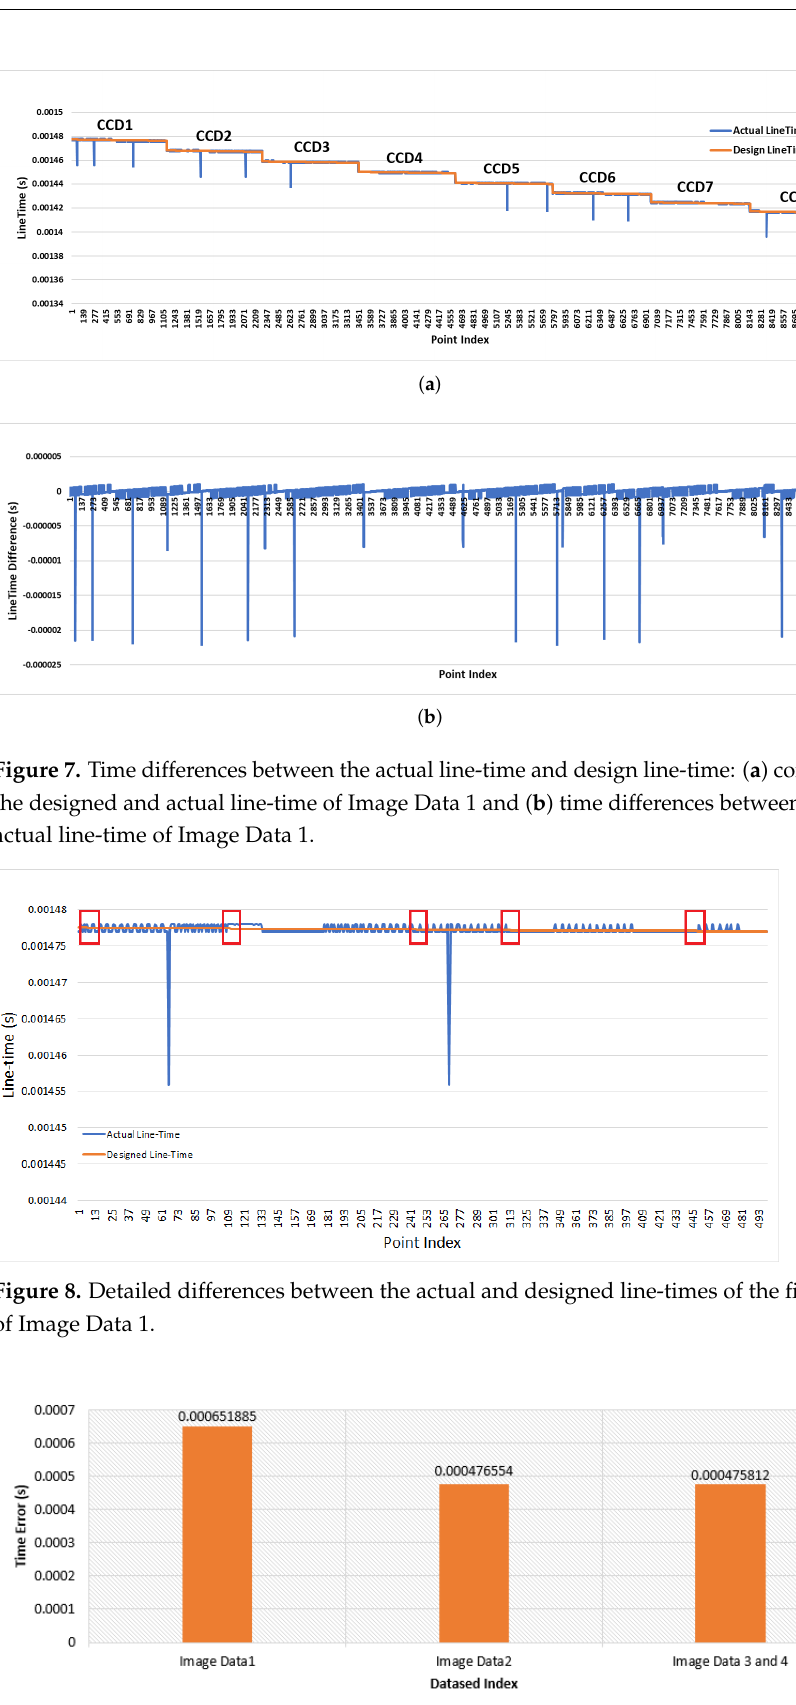
Figure 9. Accumulated time error between the actual and designed